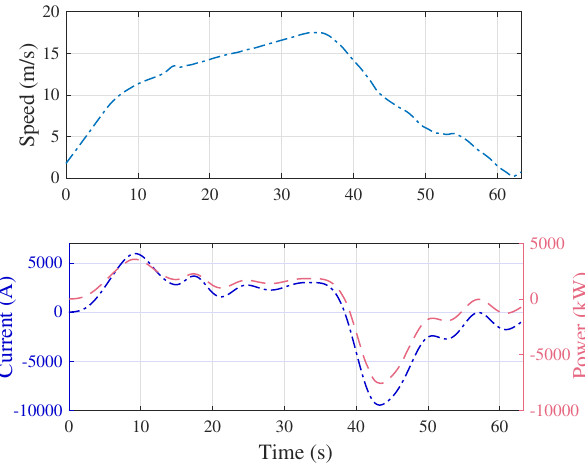
Figure 12. Speed, Current, and Power profile of train.